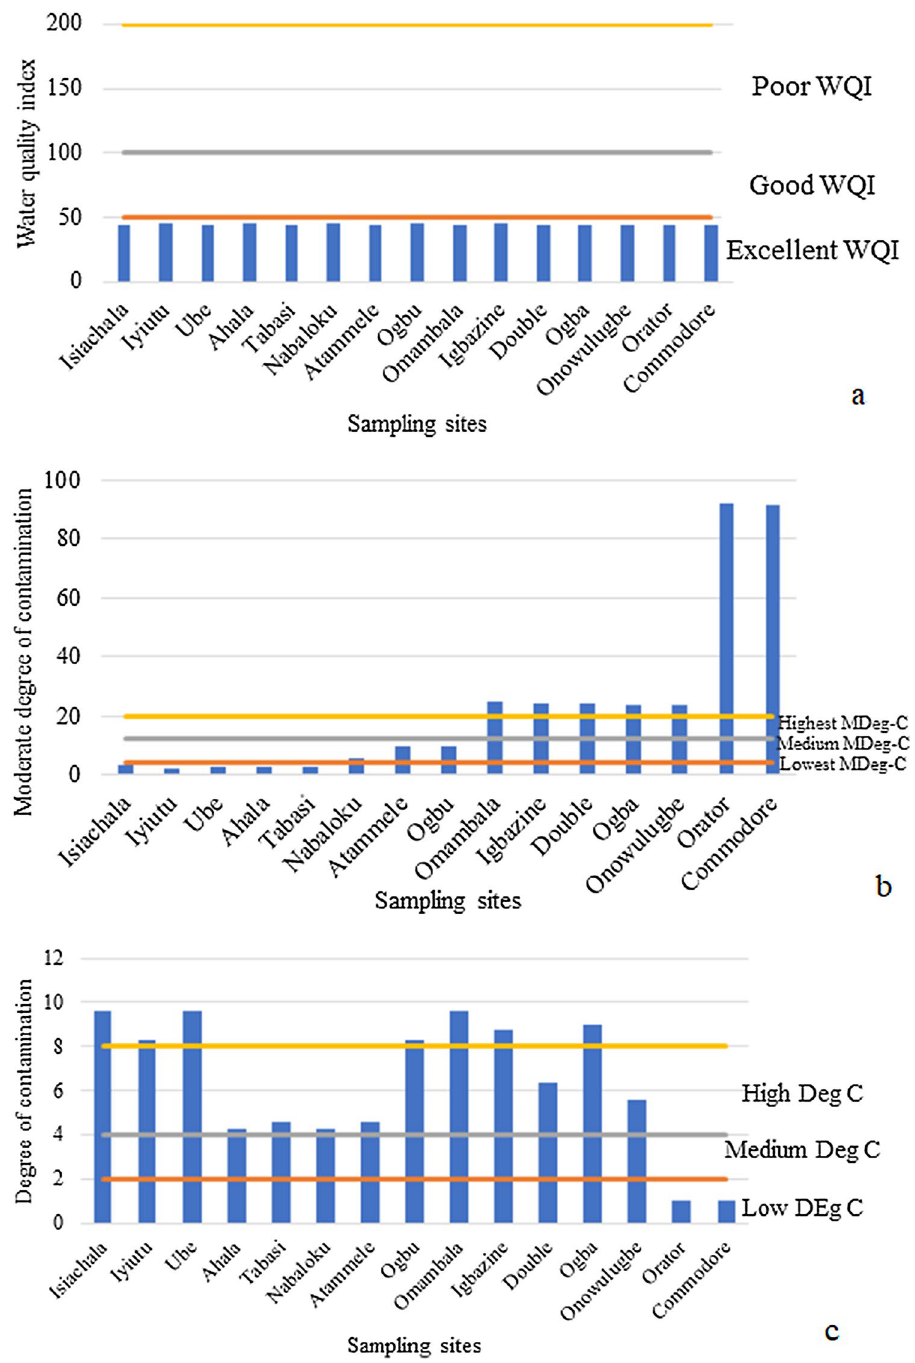
Fig. 7 Multi-elemental indices of heavy metals in water samples, a water quality indices (WQI), b Modified degree of contamination M.Deg-C and c degree of contamination